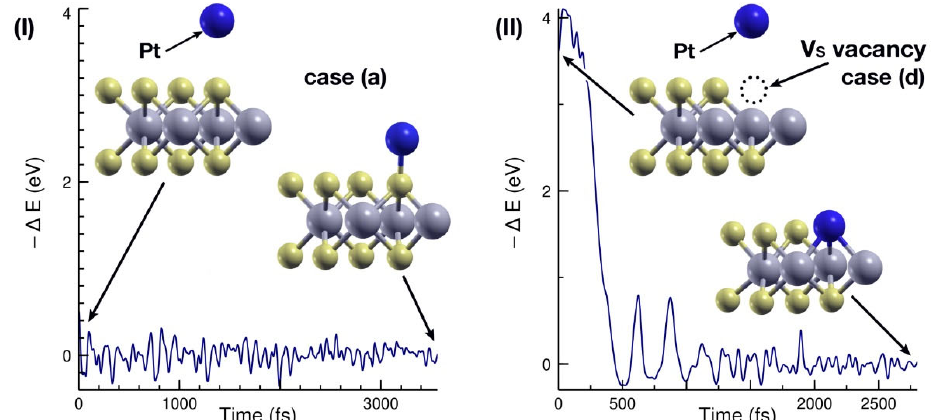
Figure 8. Energy evolution for the first principles molecular dynamics calculations performed. We considered the two extreme cases: ( I ) those with the lowest absorption energy, corresponding to case (a) in Figures 2 and 3; and ( II ) with the highest one, corresponding to case (d) in Figures 2 and 3. The FPMD calculations shown ran for 3561 and 2800 iterations, respectively. In both cases the qualitatively behavior agrees with the structural relaxation calculations previously performed.